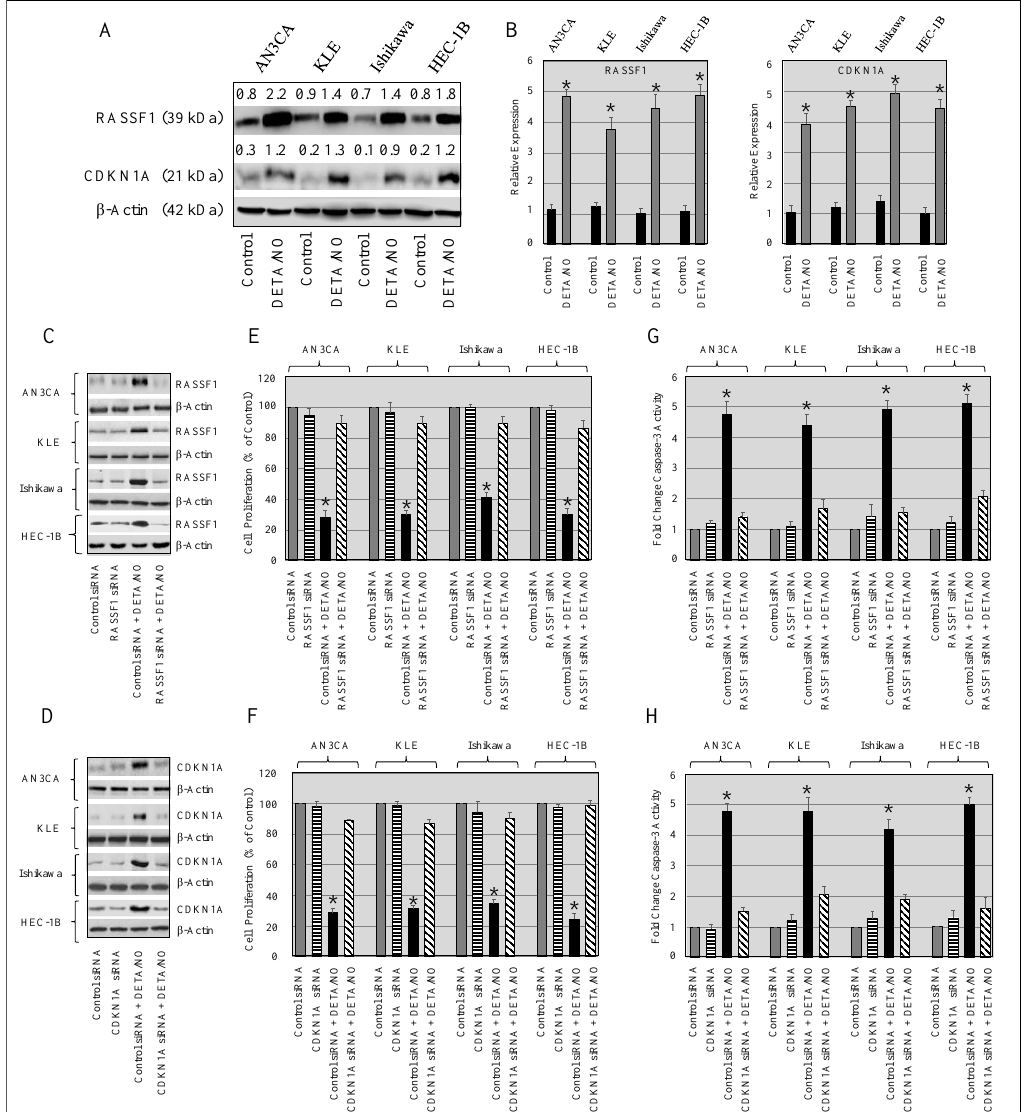
Figure 7. DETA/NO treatment of endometrial cancer cells upregulated the expression of tumor suppressor genes. ( A ) Cell lysates from DETA/NO or vehicle-treated cells were probed with CDKN1A and RASSF1 antibodies. β-Actin was used as a loading control. The values above the bands represent the relative density of the bands normalized to β-actin. ( B ) The expression of RASSF1 or CDKN1A in DETA/NO-treated and vehicle-treated cells is shown as bars after normalization to β-actin. Data are expressed as means ± SEM of three independent experiments. An asterisk * ( p < 0.05) indicates a statistically significant change between control and treatment groups. Effect of RASSF1 or CDKN1A silencing on protein expression ( C – D ), growth ( E – F ) and caspase-3 activity ( G – H ) on DETA/NO-treated and vehicle-treated cells. Data shown are mean ± SEM of values from three independent experiments. * p < 0.05 (statistically significant) between the control and treatment groups.